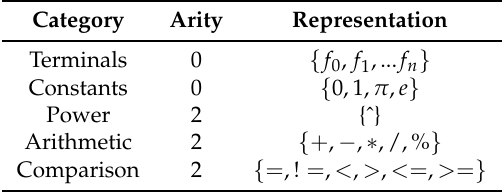
Table 1. The pool of available node values in the GEP complex feature tree.